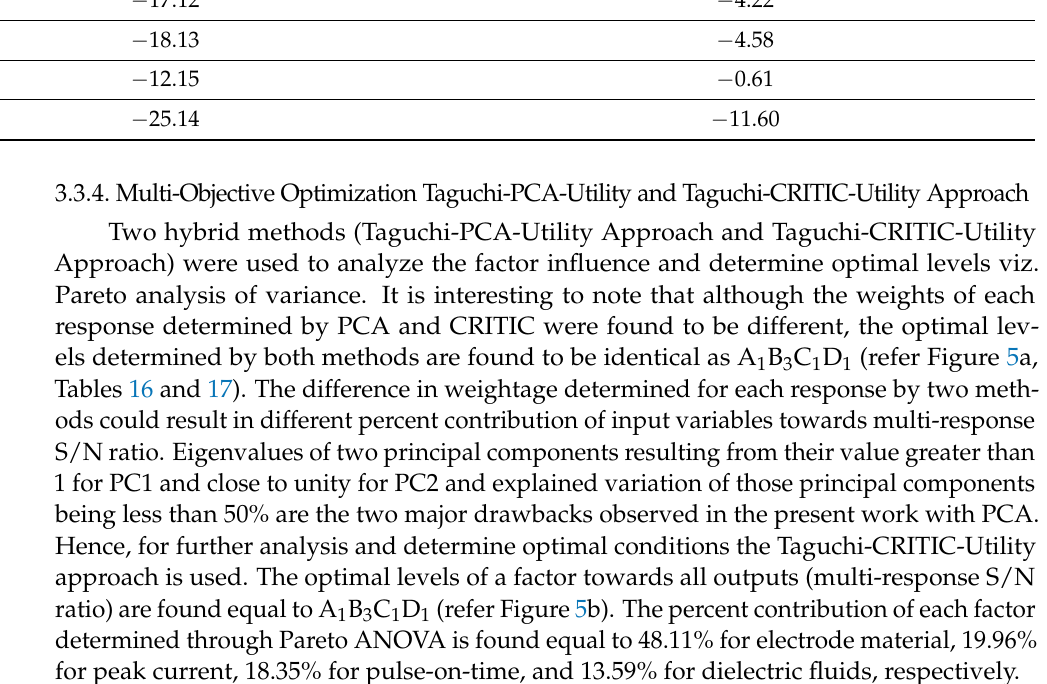
Table 16. Pareto ANOVA for the multi-response—Taguchi-PCA-Utility approach.